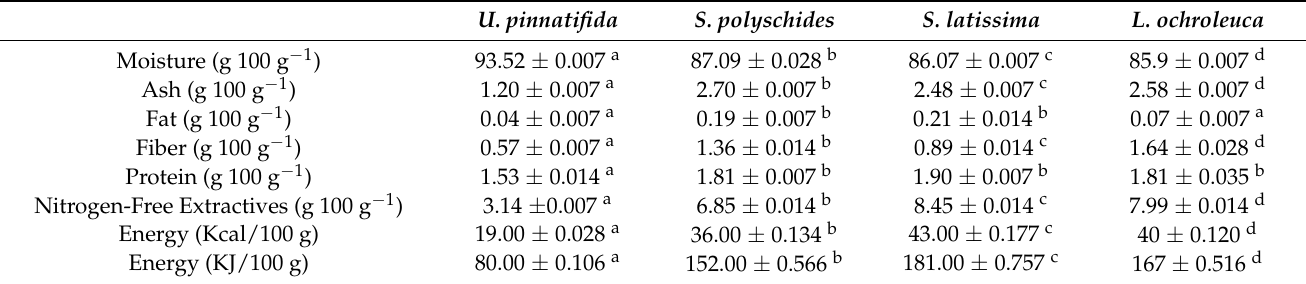
Table 2. Nutritional characterization of the fresh biomass of U. pinnatifida , S. latissima , L. ochroleuca , and S. polyschides . Results are expressed in mean ± standard error. Statistically significant differences in the same element content among the species are expressed by different letters. ( n = 2; fresh weight basis).